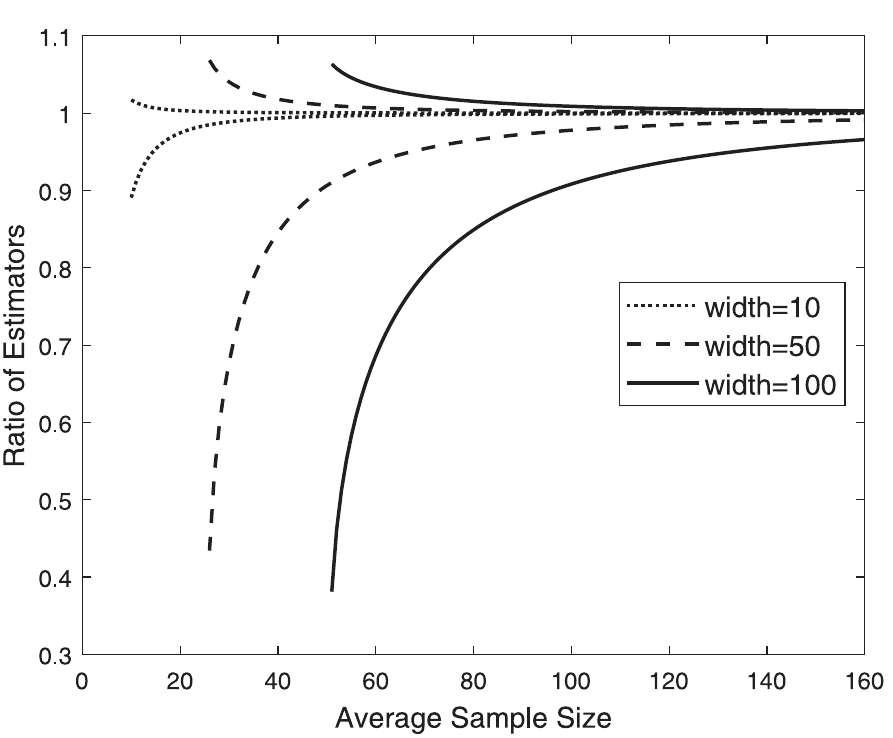
Fig 1. Ratio of ^ b uniformly distributed with varying average and width of uniform interval.